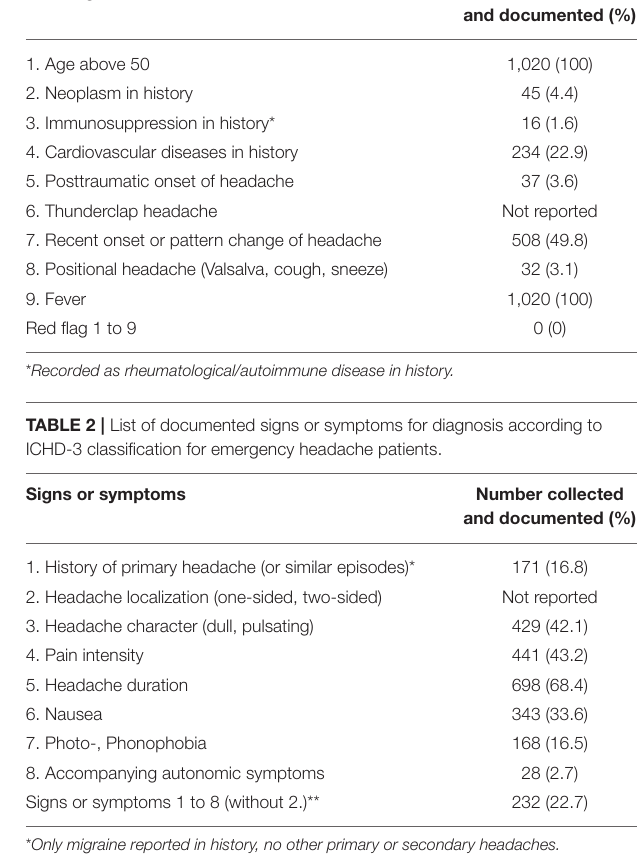
TABLE 1 | List of documented red flags (warning signs and symptoms for secondary headache) for emergency headache patients. Red flags